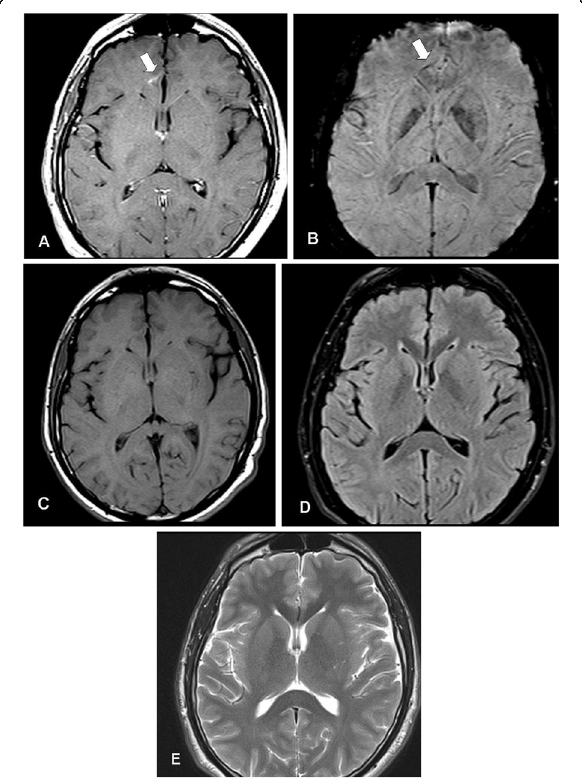
Fig. 6 Contrast-enhanced T1W ( a ) and SWI ( b ) show a small DVA in the right frontal lobe (arrow). The lesion is less clearly demonstrated on non-contrast T1W ( c ), FLAIR ( d ), and T2W ( e ) with no definite abnormality at the right frontal